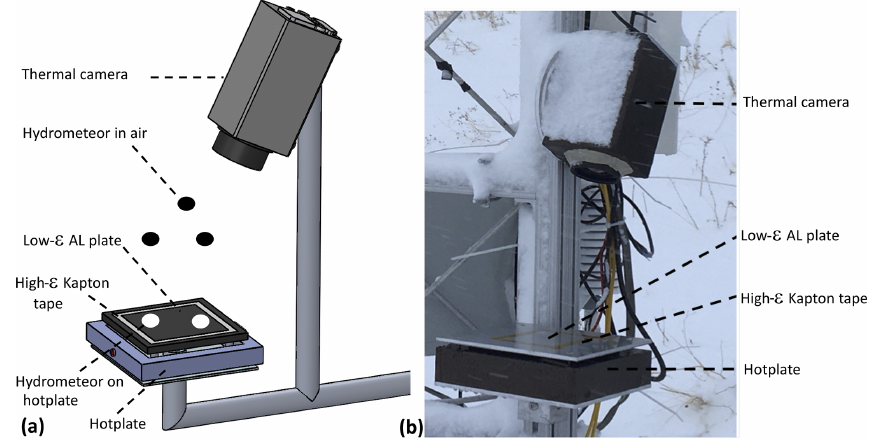
Figure 1. (a) Schematic of the DEID. The top surface of a roughened heated aluminum plate imaged by a thermal camera is dark due to its low infrared emissivity. Hydrometeors with a high emissivity that reach a high temperature on the heated plate show as bright regions from which the hydrometeor’s size and area can be measured by counting pixels. (b) Photograph of the DEID after deployment in field experiments.